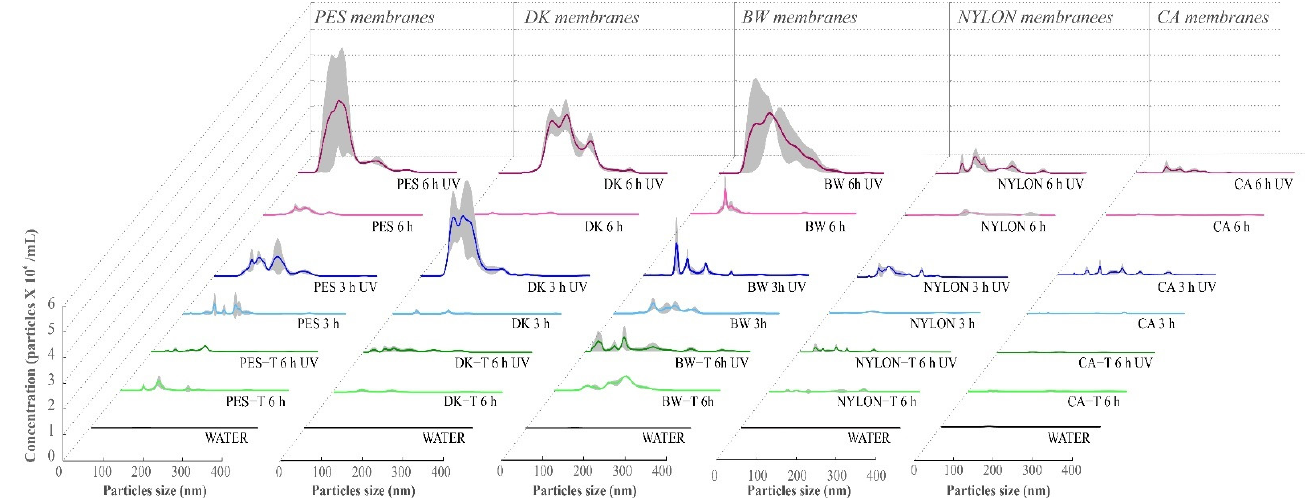
Figure 8. Nanoparticle tracking analysis (NTA) of the aqueous media (WATER) in contact with the unmodified and modified membranes after 3 or 6 h exposure to UV radiation. The gray regions show the variation of results obtained in four replicate experiments. Non-modified membranes: Polyethersulfone (PES, 0.2 µm), Cellulose Acetate (CA, 0.45 µm), Polyamide–Nylon (NYLON, 0.45 µm), DK and BW; and modified membranes: PES-T, CA-T, NYLON-T, DK-T, and BW-T. Table 1. Concentration of nanoparticles present in aqueous media for polymeric membranes not exposed and exposed to UV radiation (3 or 6 h) before and after sol–gel modification with TiO 2 . Non-modified membranes: Polyethersulfone (PES, 0.2 µm), Cellulose Acetate (CA, 0.45 µm), Polyamide–Nylon (NYLON, 0.45 µm), DK and BW; and modified membranes: PES-T, CA-T, NYLON-T, DK-T, and BW-T. 3 h UV *